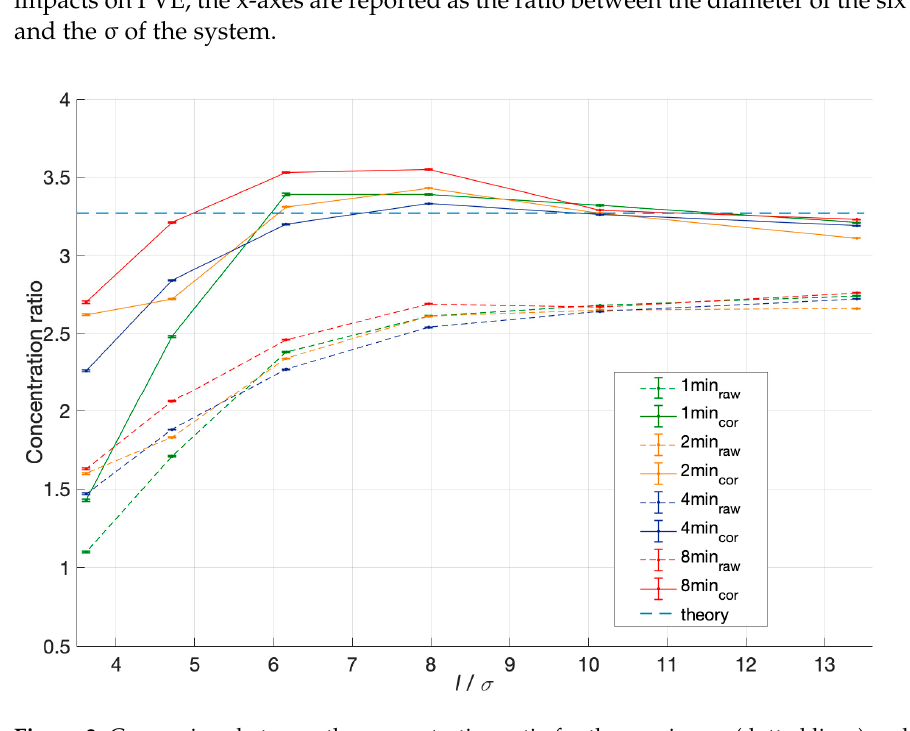
Figure 4. Comparison of the concentration ratio for the same acquisition time (4 min) between the reconstruction with TOF correction, reported in red, and the one without TOF, reported in blue, before (dotted line) and after (continuous line) the application of PVE recovery method.